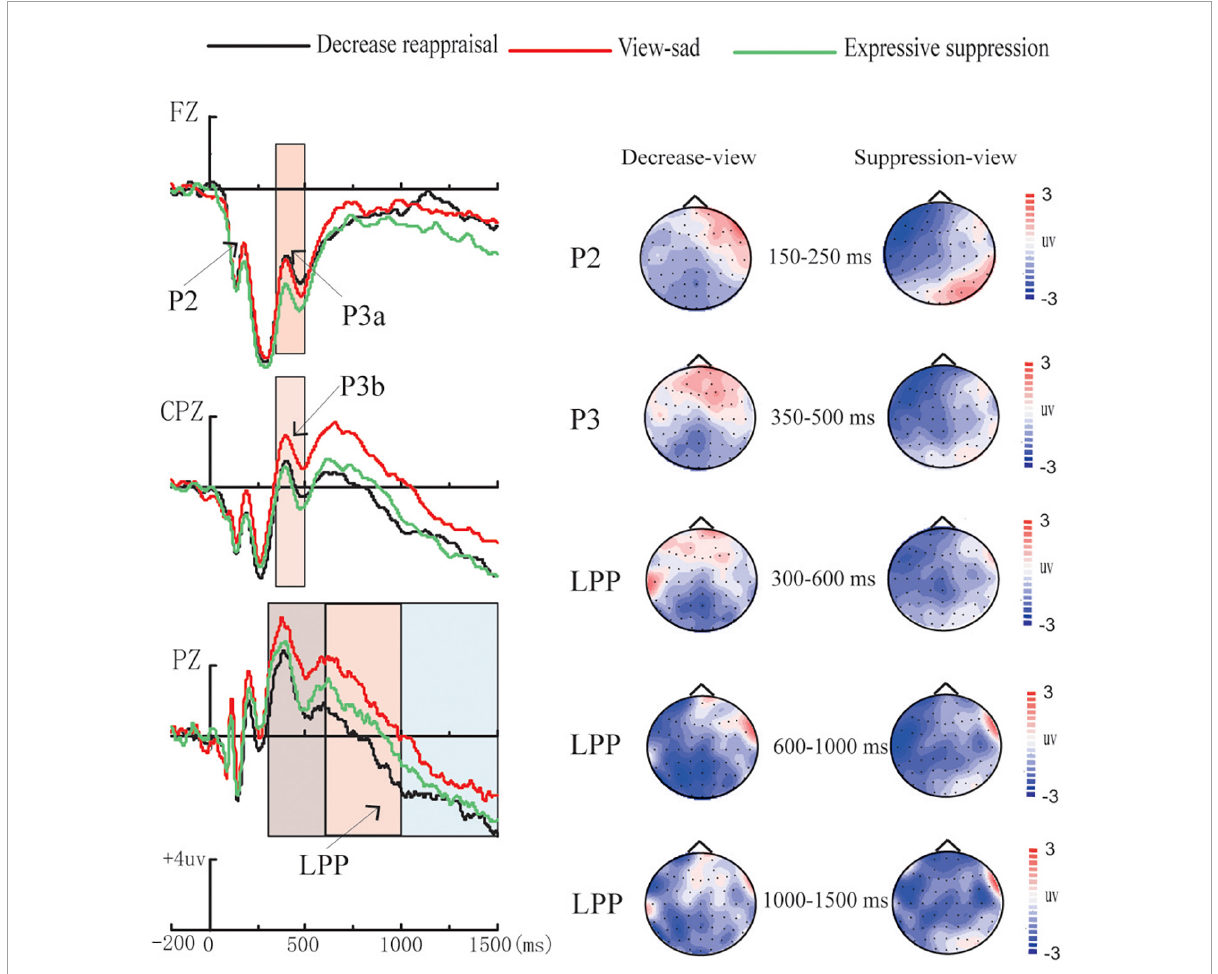
FIGURE4 Amplitude distribution and topographic map of ERPs during regulation. Amplitude distribution and topographic map of ERP measurements involving the effects of down-regulation reappraisal and expressive suppression on the regulation of